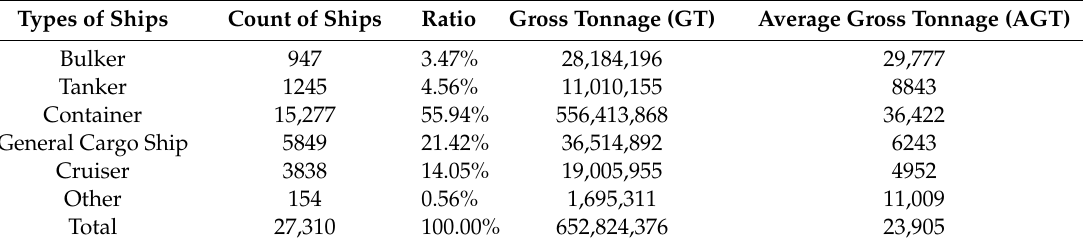
Table 6. Ship Analysis of Busan Port in